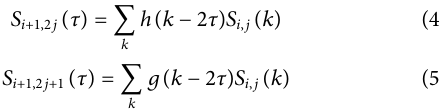
Figure 3B. Each FHR signal segment is converted into a total of 5 feature maps based on db1~db5 wavelet bases.